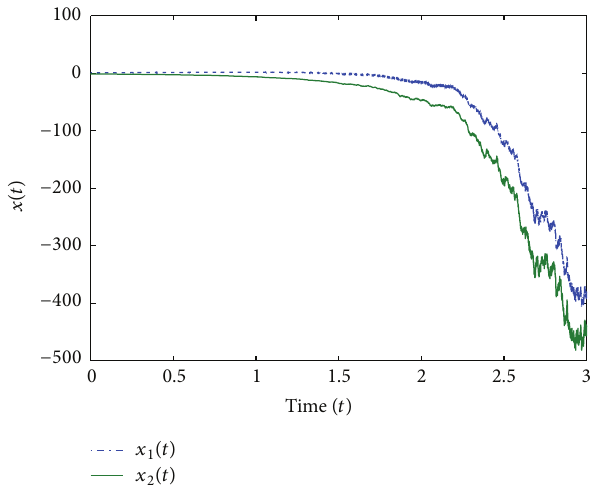
Figure 1: The solution to system (51) without impulses (single sam- ple).